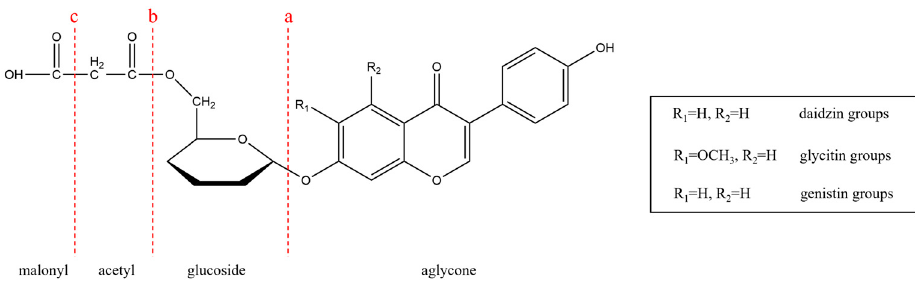
Figure 1. Chemical structures of 12 natural isoflavones.